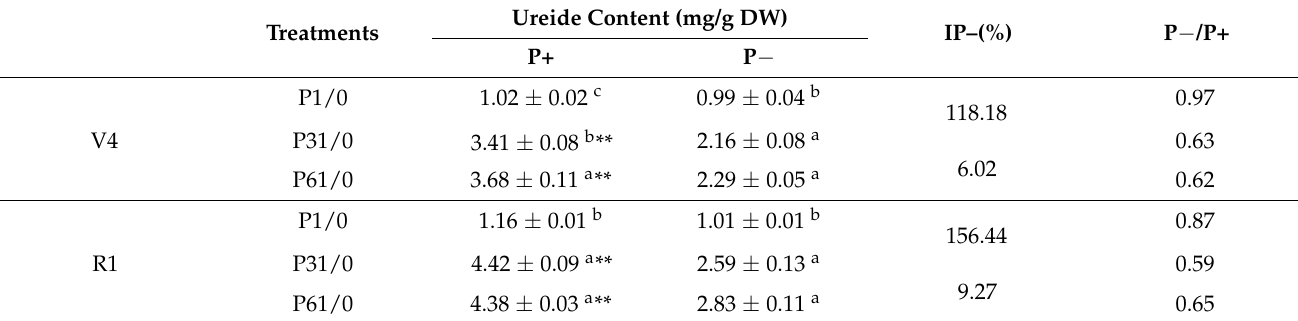
Table 4. Effect of P supply on the ureide content in nodules of dual-root soybeans. Ureide Content (mg/g Treatments